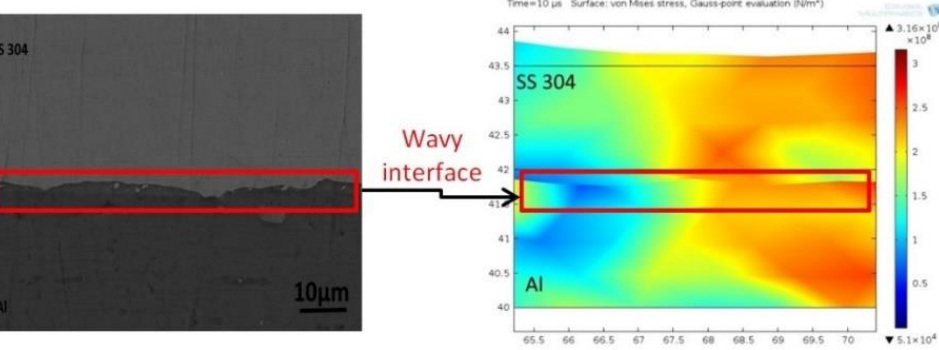
Figure 6. Comparison of interface morphology between experimental test and FEM model.